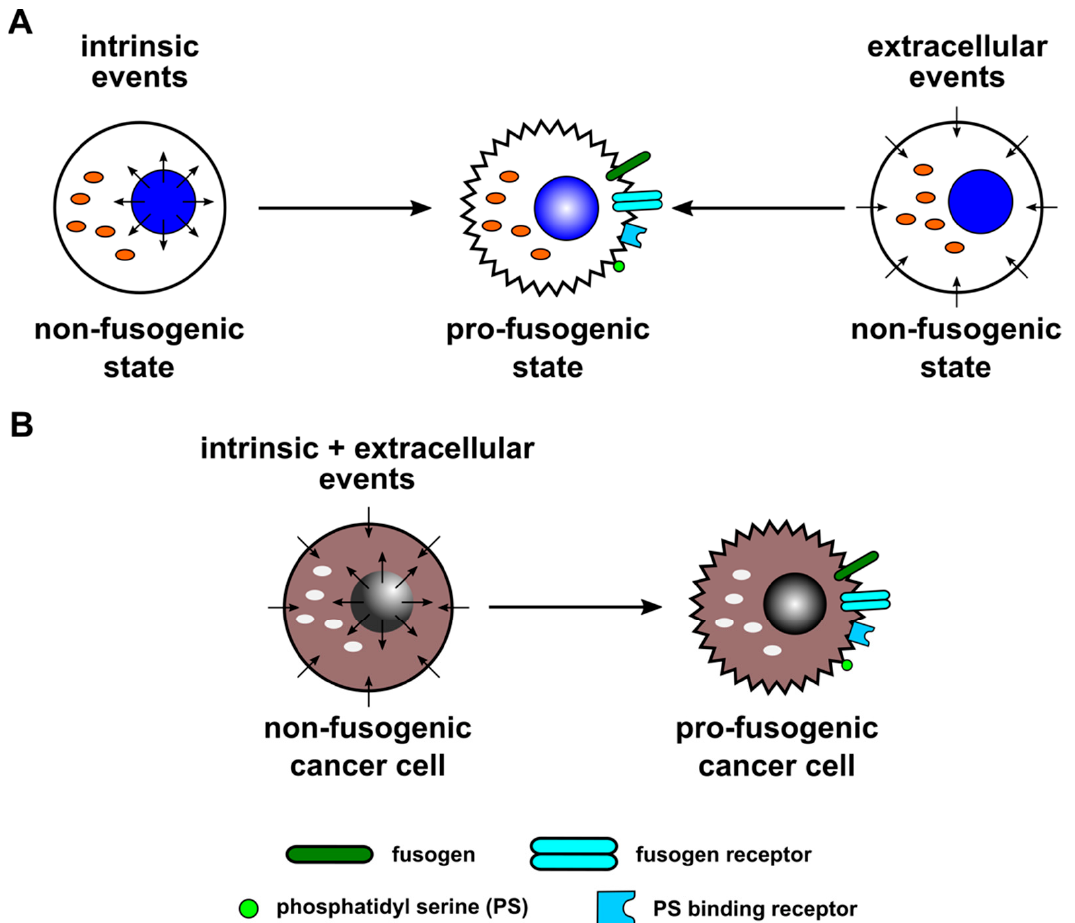
Figure 1. Both intrinsic and extracellular events can convert cells to a pro-fusogenic state, as postulated in this hypothetic model. ( A ) Intrinsic events likely play a role in physiological cell–cell-fusion-dependent processes, such as placentation and myogenesis. Here, intrinsic events lead to time-dependent and developmental-state-dependent expression of the major components of the cell–cell fusion machinery, which ensures a high frequency of cell–cell fusion events. In addition, extracellular events could also convert cells towards a pro-fusogenic state, which would enable BMDCs in tissue regeneration. In a normal state, BMDCs are non-fusogenic but could be converted into a pro-fusogenic state, which is most likely triggered by damaged tissue-derived extracellular signals. ( B ) Cancer cells could fuse either spontaneously or following induction, suggesting that both intrinsic and/or extracellular events are controlling this process.